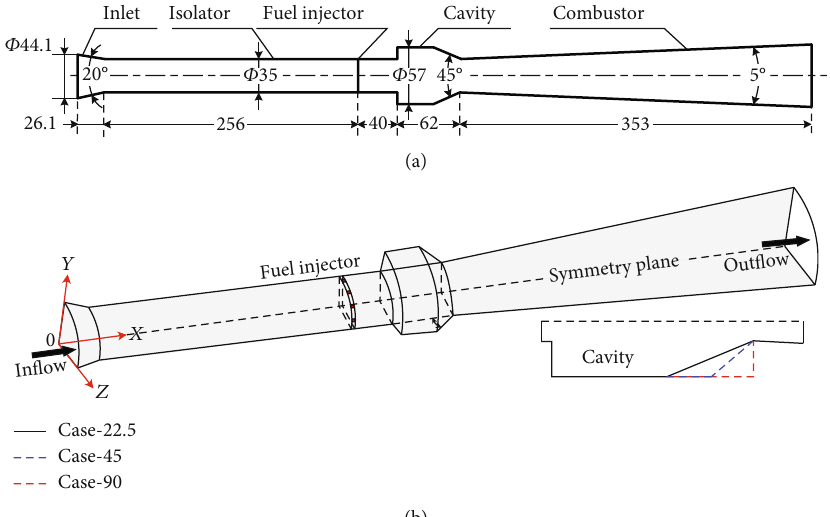
Figure 1: Schematic of (a) size of the axisymmetric scramjet [23] and (b) one-quarter of the three-dimensional con fi guration for simulation (units in mm).